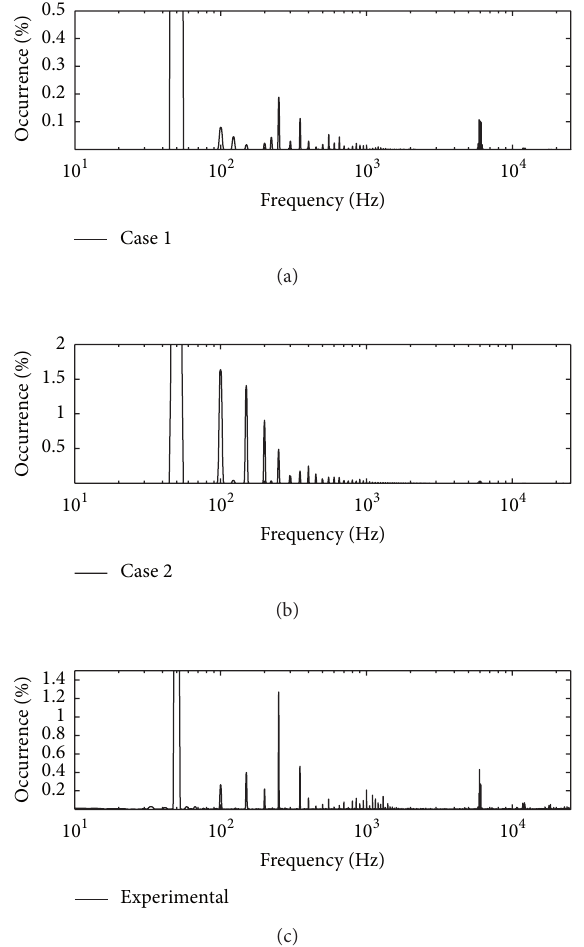
Figure 9: FFT of phase A at nominal power. (a) Case 1. (b) Case 2. (c) Experimental. We see that there are more low order harmonics in the Case 2 simulation than in Case 1. The occurrence is presented as percent of the first harmonic, that is, (𝐼 ℎ /𝐼 1 )